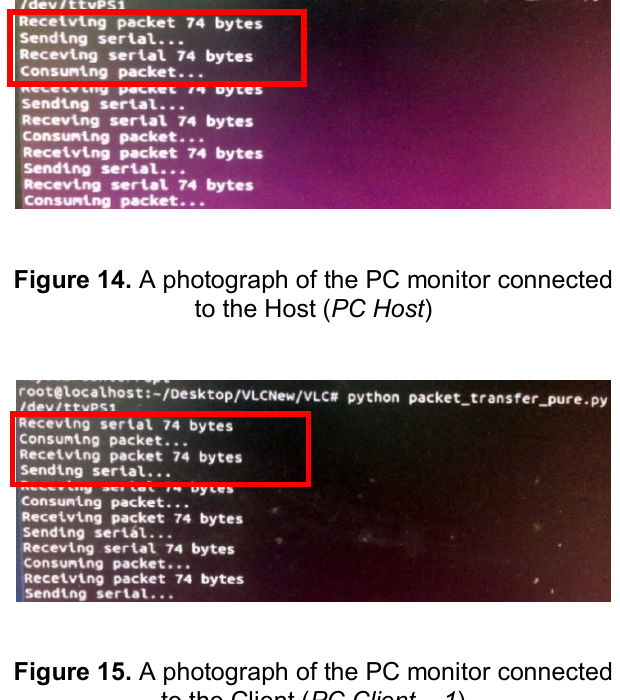
Figure 15. A photograph of the PC monitor connected